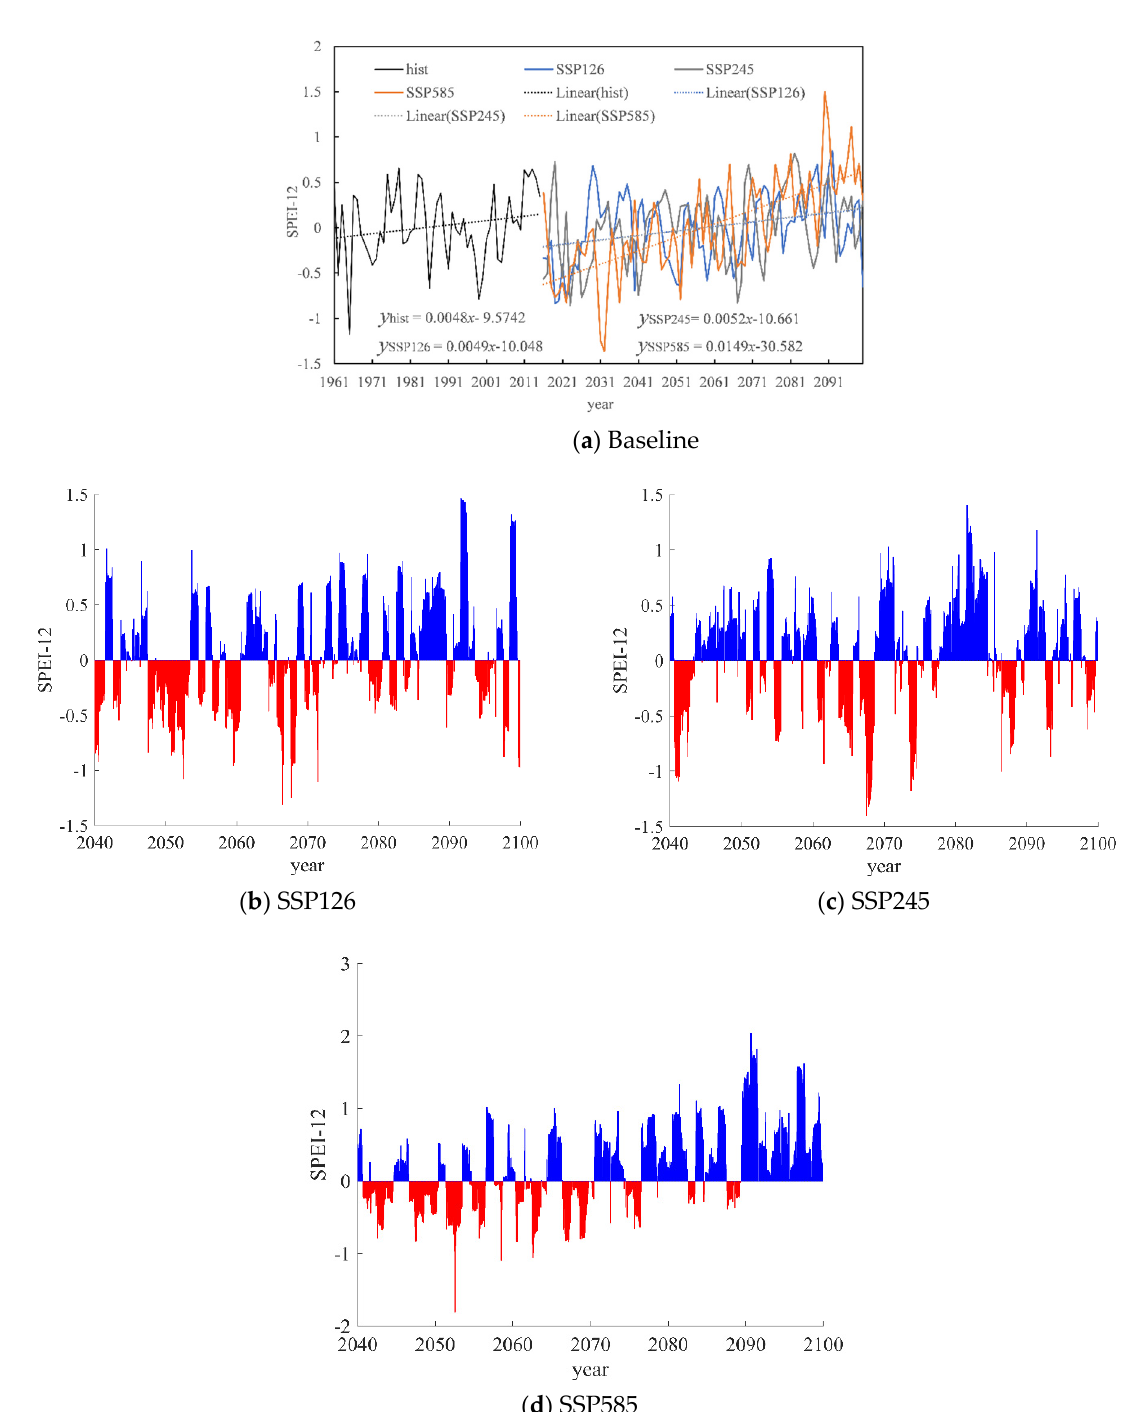
Figure 7. SPEI-12 of SSP126, SSP245, and SSP585 over 2040–2099 for the Yellow River